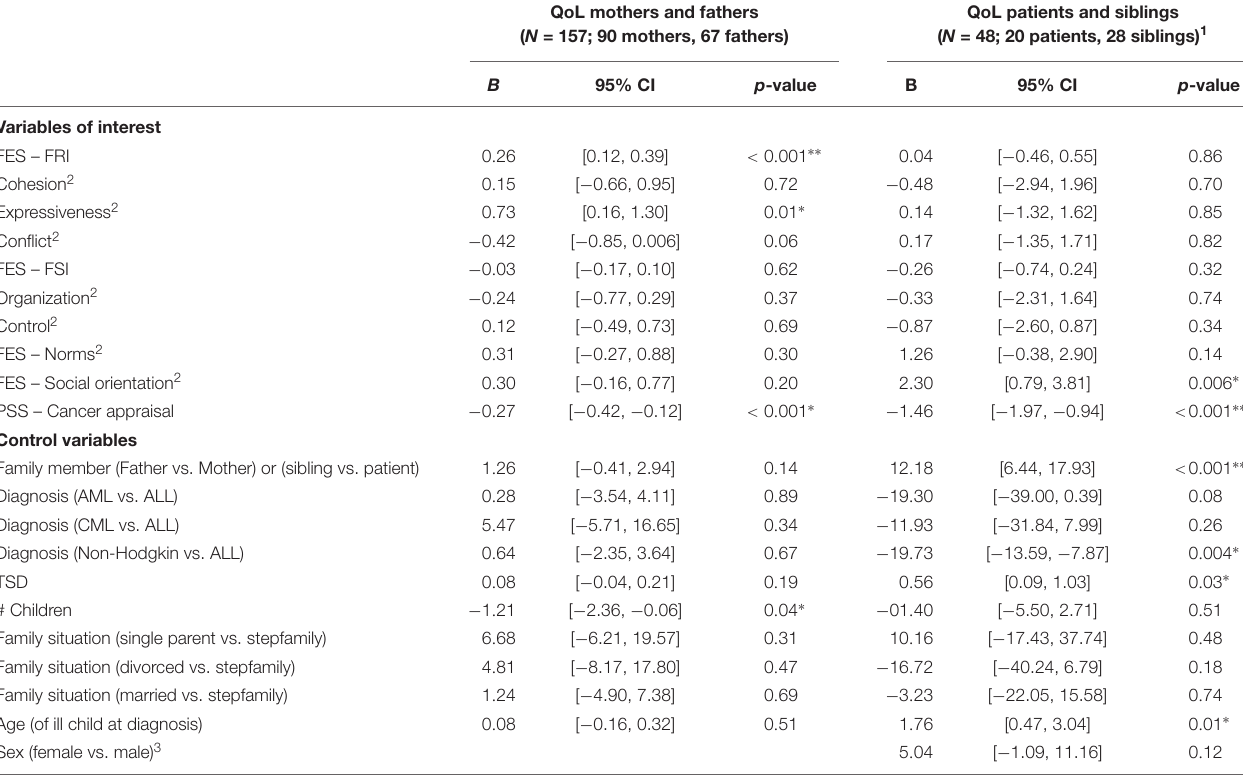
TABLE 4 | Final models for the associations between family functioning, cancer appraisal and reported quality of